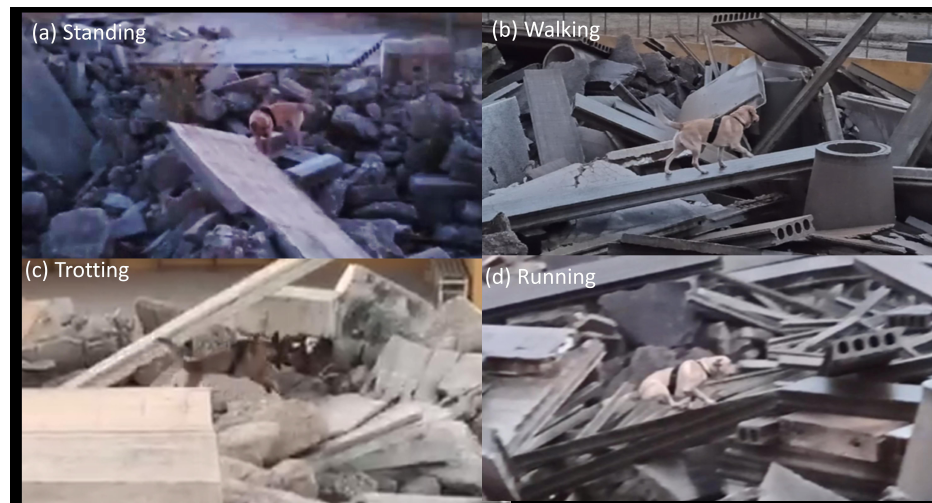
Figure 6. Instances of four